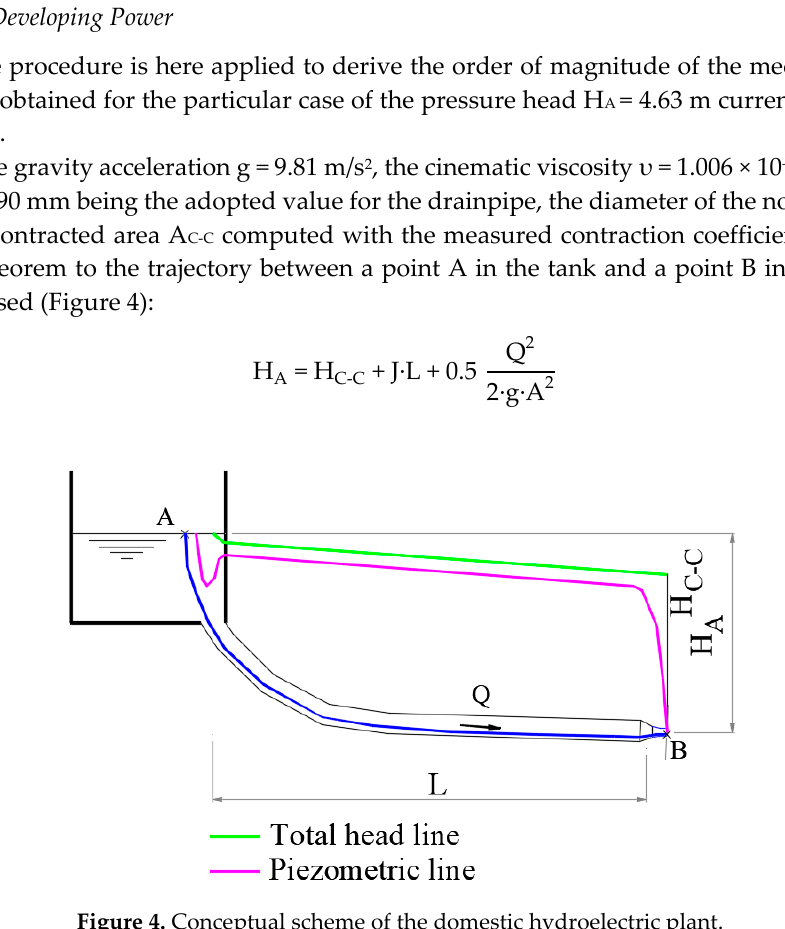
Figure 4. Conceptual scheme of the domestic hydroelectric